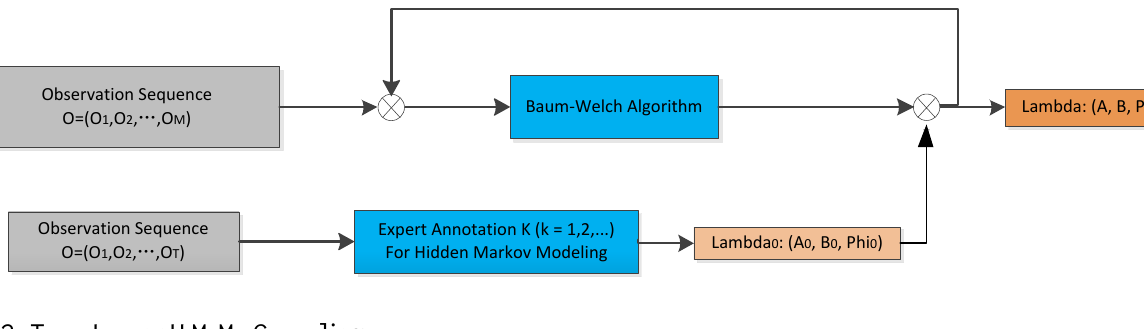
Figure 10. Expert-annotation assisted Baum-Welch algorithm for ECG Hidden Markov